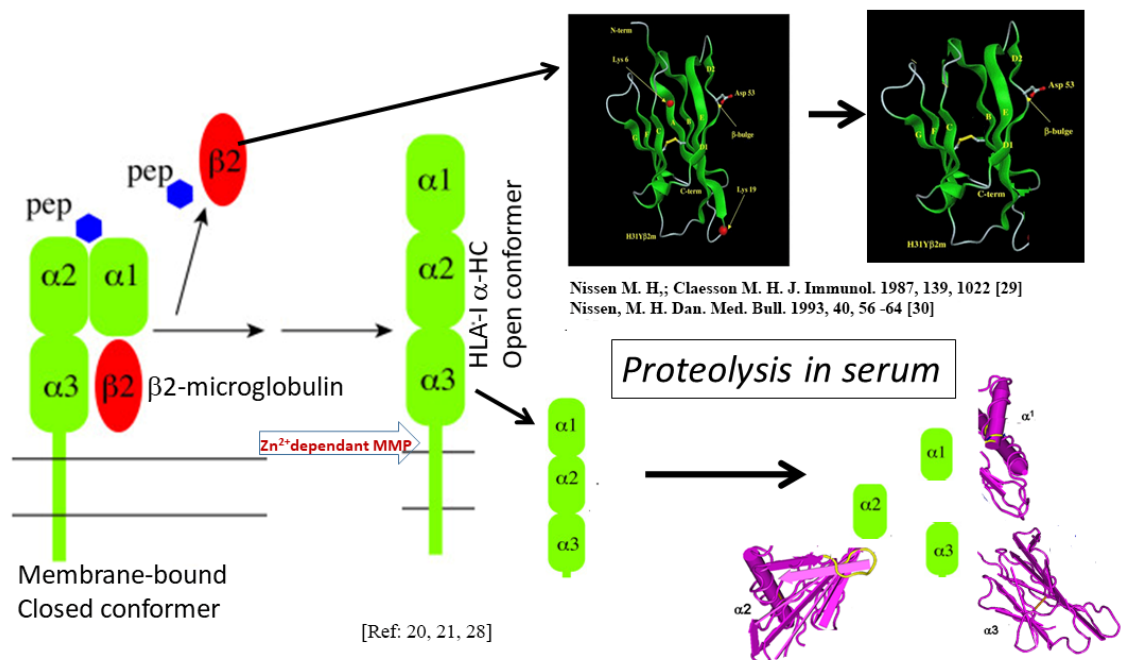
Figure 3. Shedding of membrane-bound CC and the shedding results in dissociation of HLA α -HC from β 2m. The membrane-bound α -HC is cleaved by a Zn 2+ -dependent membrane metalloproteinase. The shed α -HC and β 2m are further degraded. Immune recognition of shed β 2m and α -HC can occur at any time [29,30].